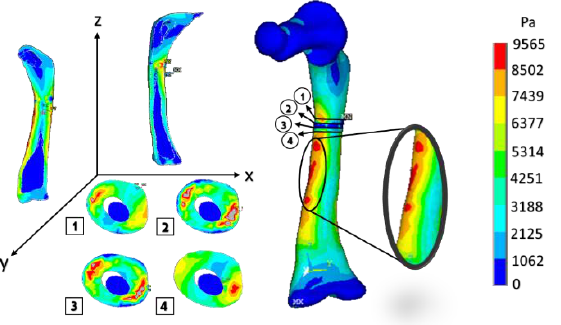
Figure 13. Orthotropic analysis. Von Mises stress showing maximum stress of 9.565 Pa.